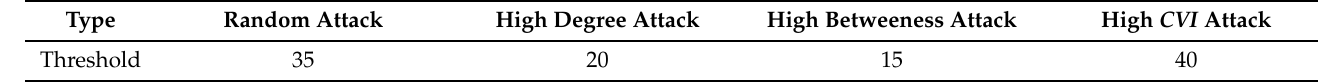
Figure 7. Nodes survived under different attacks. Table 4. The thresholds of different attacks.